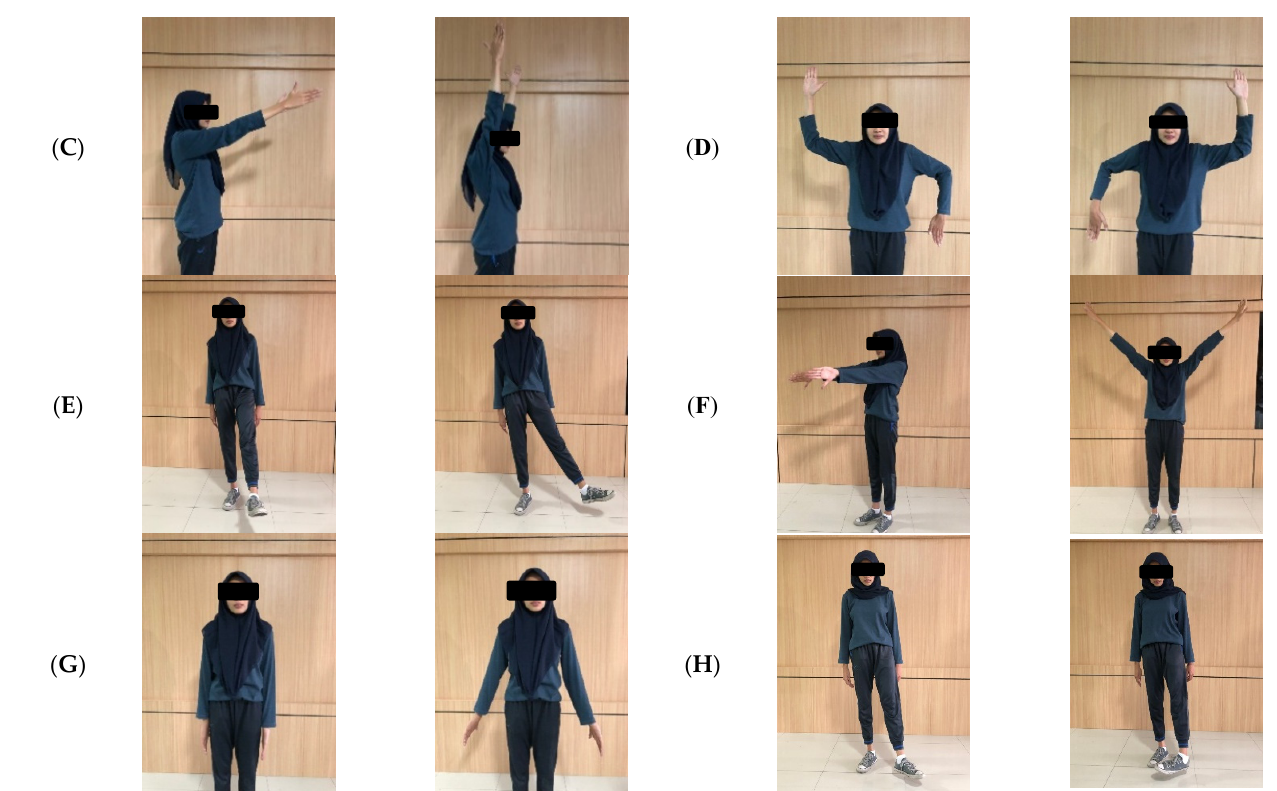
Figure 3. ( A ) Supraspinatus muscle; ( B ) teres major muscle; ( C ) serratus anterior muscle; ( D ) subscapular muscle; ( E ) psoas muscle; ( F ) pectoralis major sternalis muscle; ( G ) latissimus dorsi; ( H ) peroneus muscle.